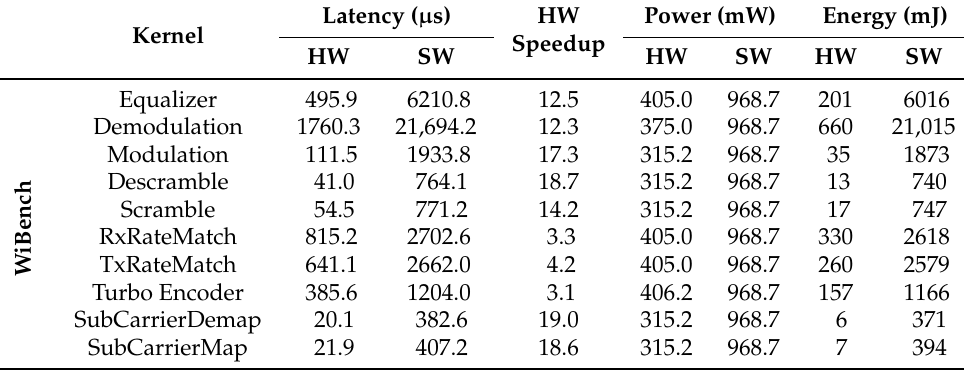
Table 2. The energy, power consumption, and execution time of different kernels on XCZU3EG- SBVA484 FPGA with 250 MHz clock frequency and ARM Cortex-A53 processor (only one core) with 1.5 GHz